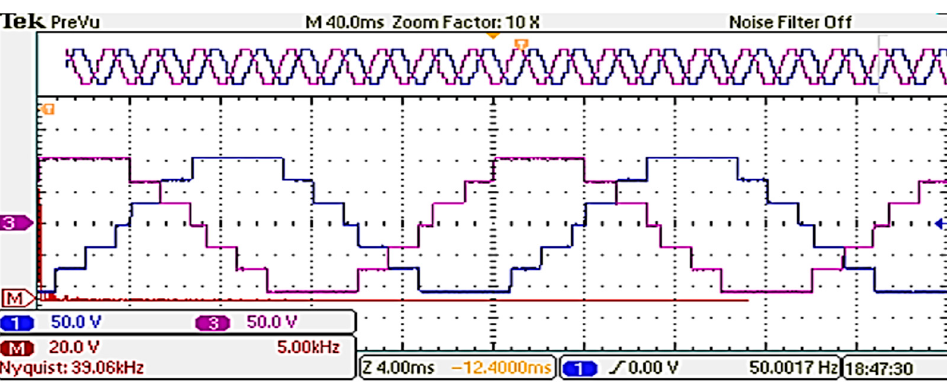
Figure 11. Laboratory experimental test setup of three-phase seven-level inverter.